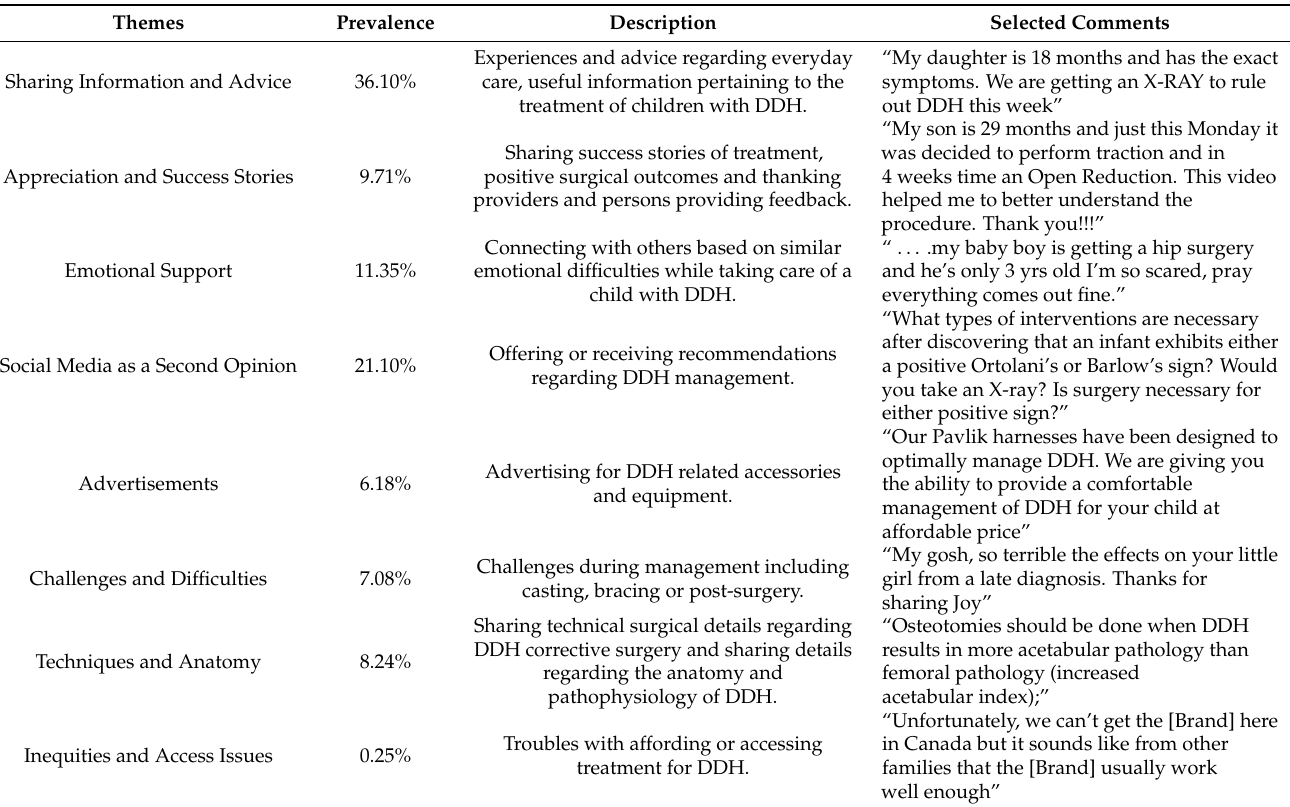
Figure 2. Social media account categories. Table 1. Thematic analysis of overall